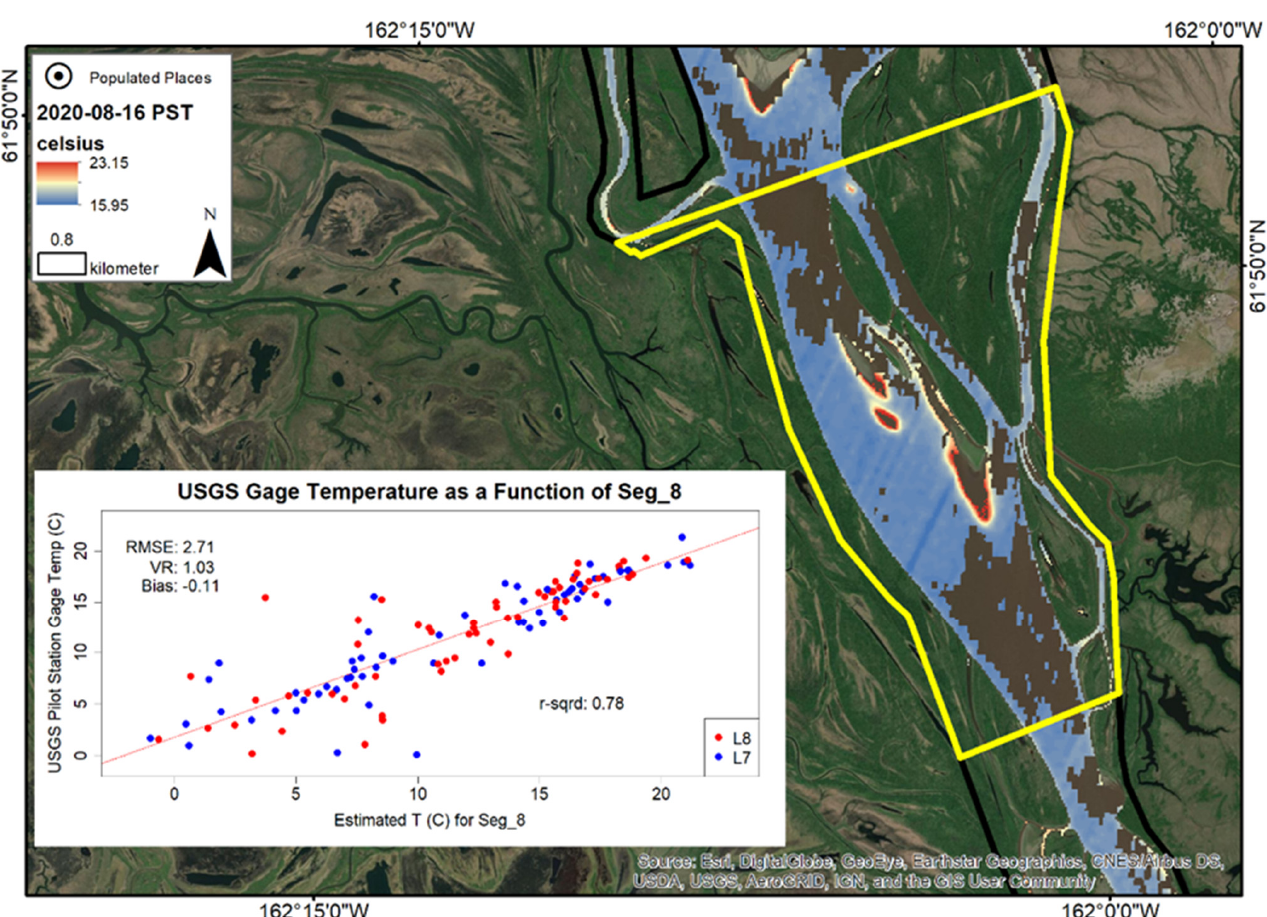
Figure A6. Segment 8 of the Yukon River intercepts a large island (Arbor Island) mid-section with Wilson Creek Slough passing to the east and the majority of the Yukon passing to the west. Several smaller but permanent islands are present as indicated by complete and dense shrub/forest cover. Smaller islands may appear at low stage. Two large NoData gaps happen to occupy the segment. The Ilivit Mountains rise on the east side of the river, while wetlands occupy the west side. This segment has slightly lower water temperature correlation than preceding river segments although it is still good overall (RMSE = 2.71 °C, r 2 = 0.78).